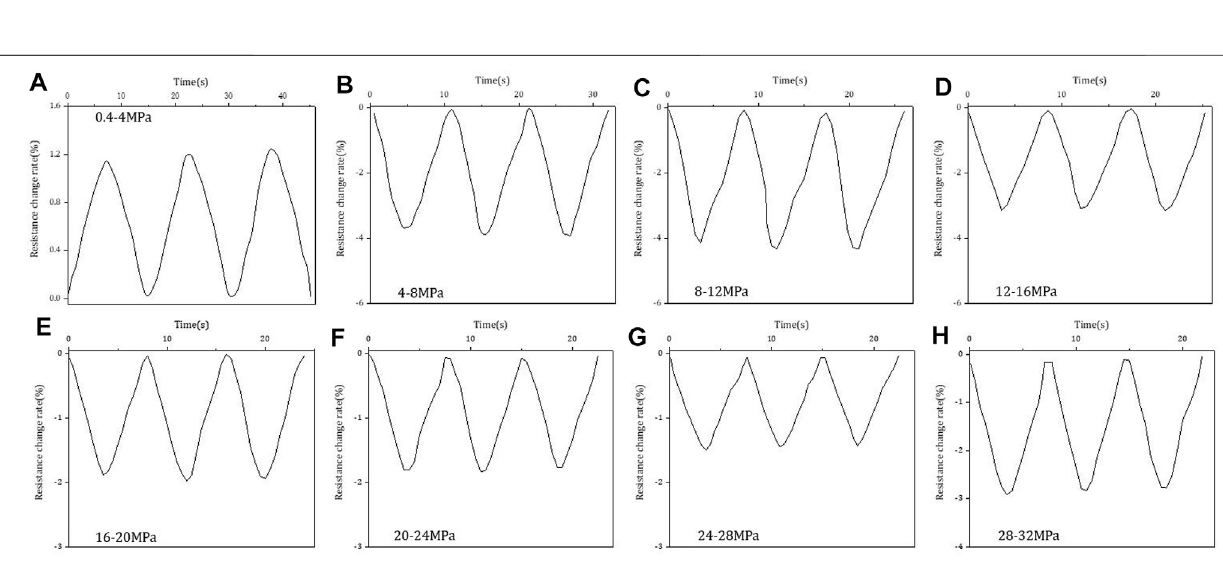
Frontiers in Built Environment |